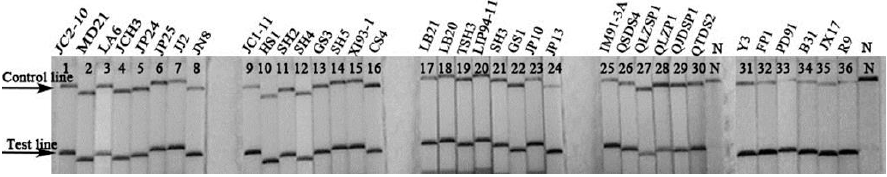
Figure 1. Results of recombinase polymerase amplification with lateral flow (LF-RPA) assay in 36 strains of Borrelia burgdorferi ( B. burgdorferi ) detection. N stands for negative control (water); Name of each strain was listed above the